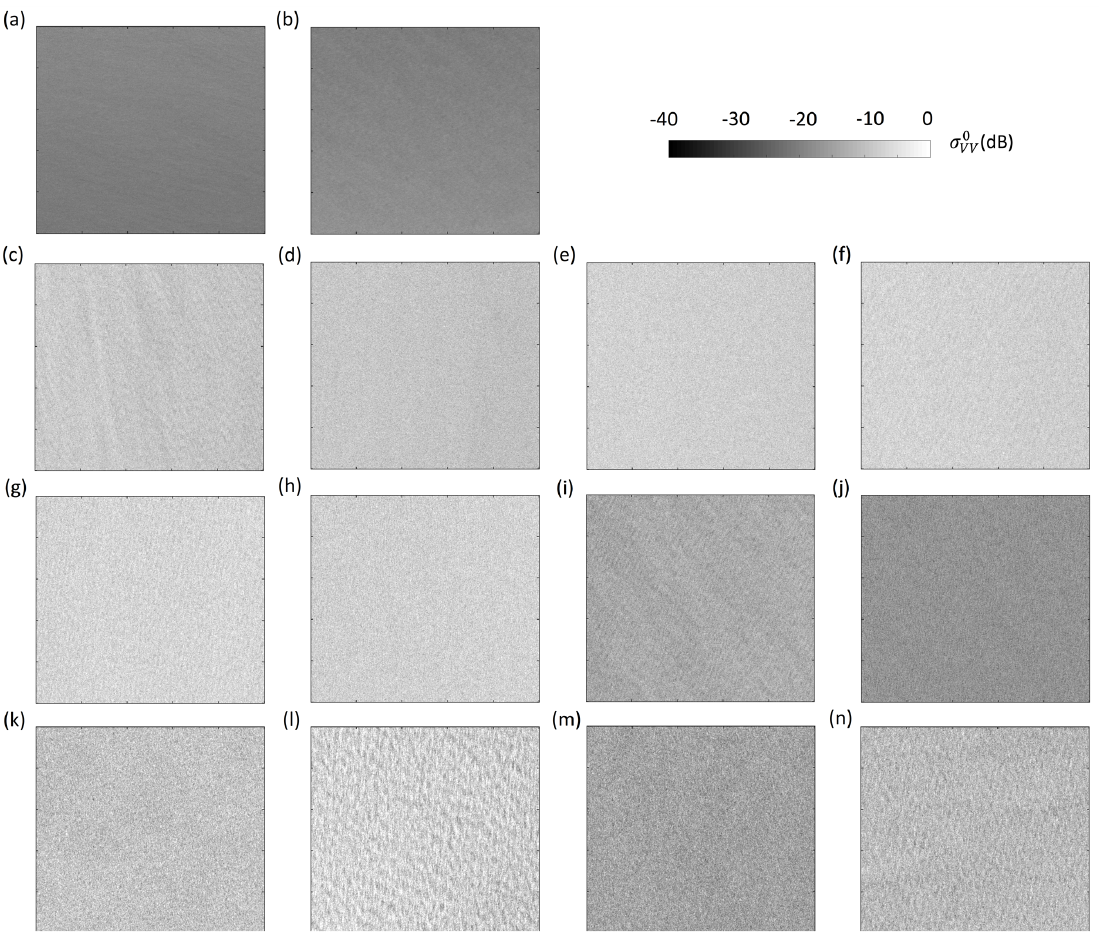
Figure 1. SAR dataset. VV-polarized intensity images (excerpts’ size: 1000 × 1000), in dB scale, over homogeneous sea surface area. Rows refer to the different SAR sensors: ( a , b ) UAVSAR; ( c – f )